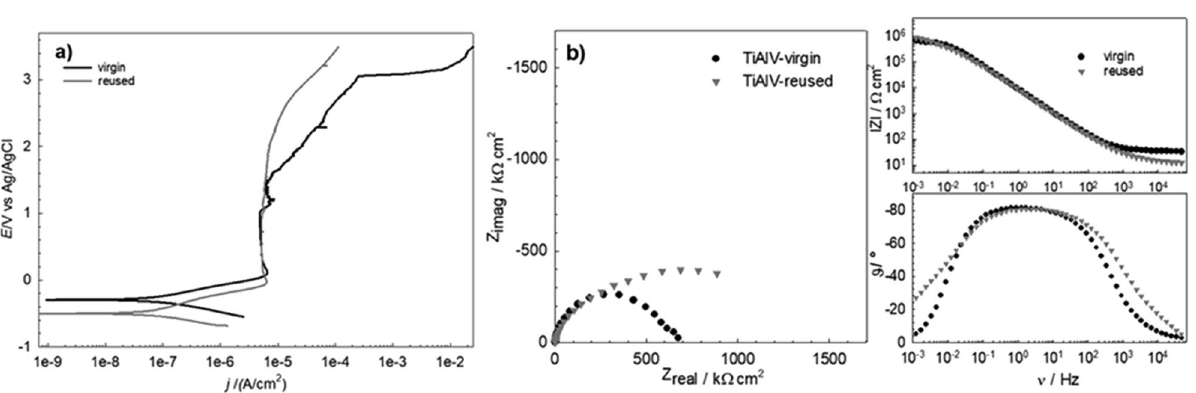
Figure 11. Potentiodynamic polarization curves ( a ) and Nyquist and Bode plots ( b ) for the Ti6Al4V alloys 3D printed from virgin and reused powder in artificial saliva with NaF.